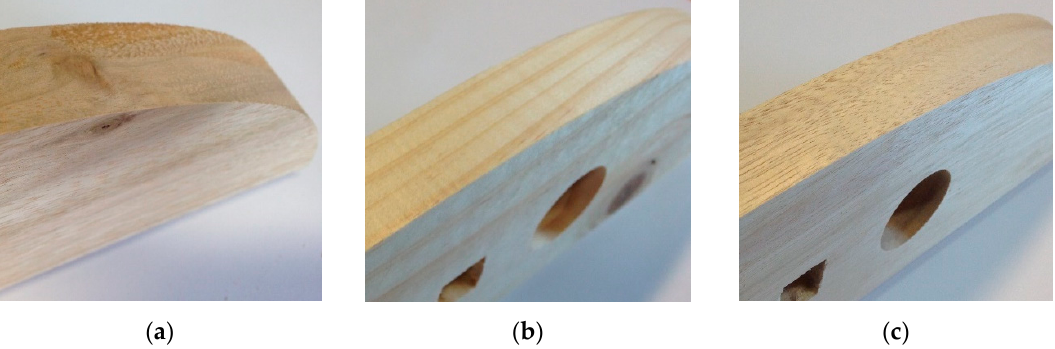
Figure 6. Examples of E. globulus ( a ) with a grade of G4 (poor) and P. radiata ( b ) and E. nitens ( c ) with a grade of G0 (excellent) for fuzzy routing side grain. Table 2. Grading results according to routing side grain.